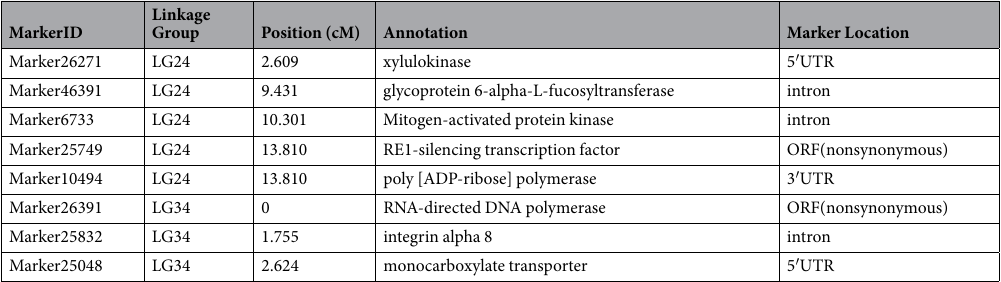
Table 7. Statistics of growth-related genes.